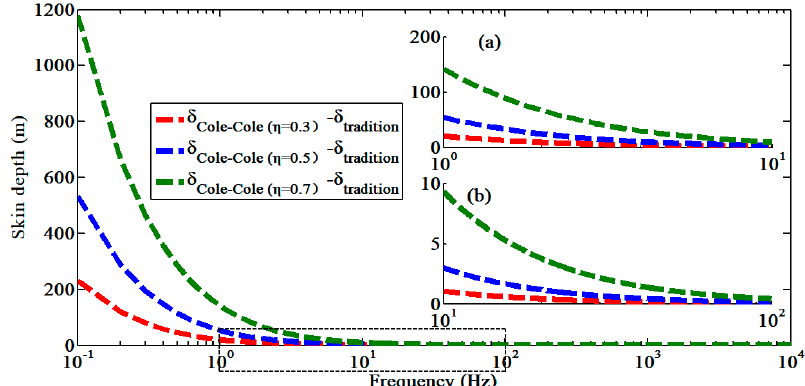
Figure 5. Absolute error between the generalized skin depth of polarized media and classical skin depth under different chargeability values (( a ) and ( b ) represent magnified maps of different frequencies; red, blue, and green represent the absolute errors when the chargeability is 0.3, 0.5, and 0.7, respectively).